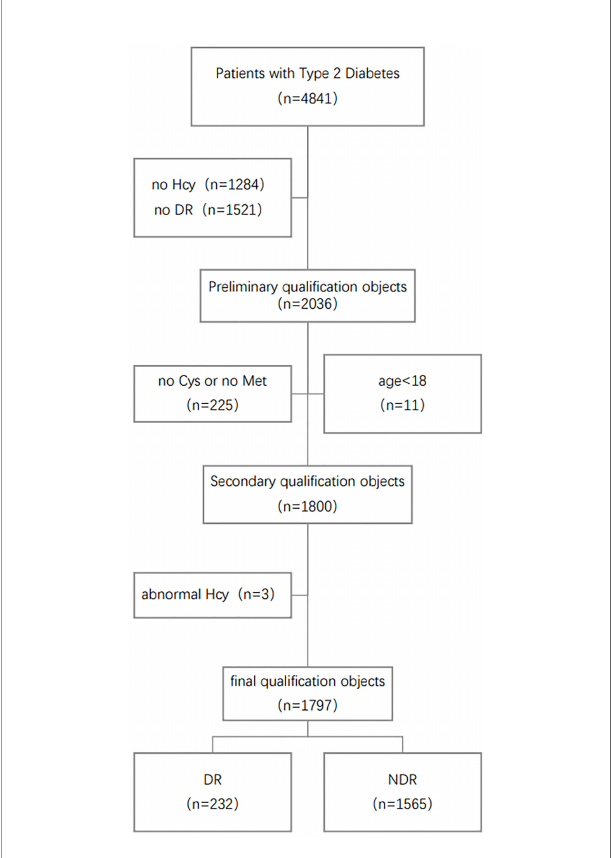
FIGURE 1 | Schematic diagram of subject screening process. Hcy, Homocysteine; Met, Methionine; Cys, Cysteine; DR, Diabetic